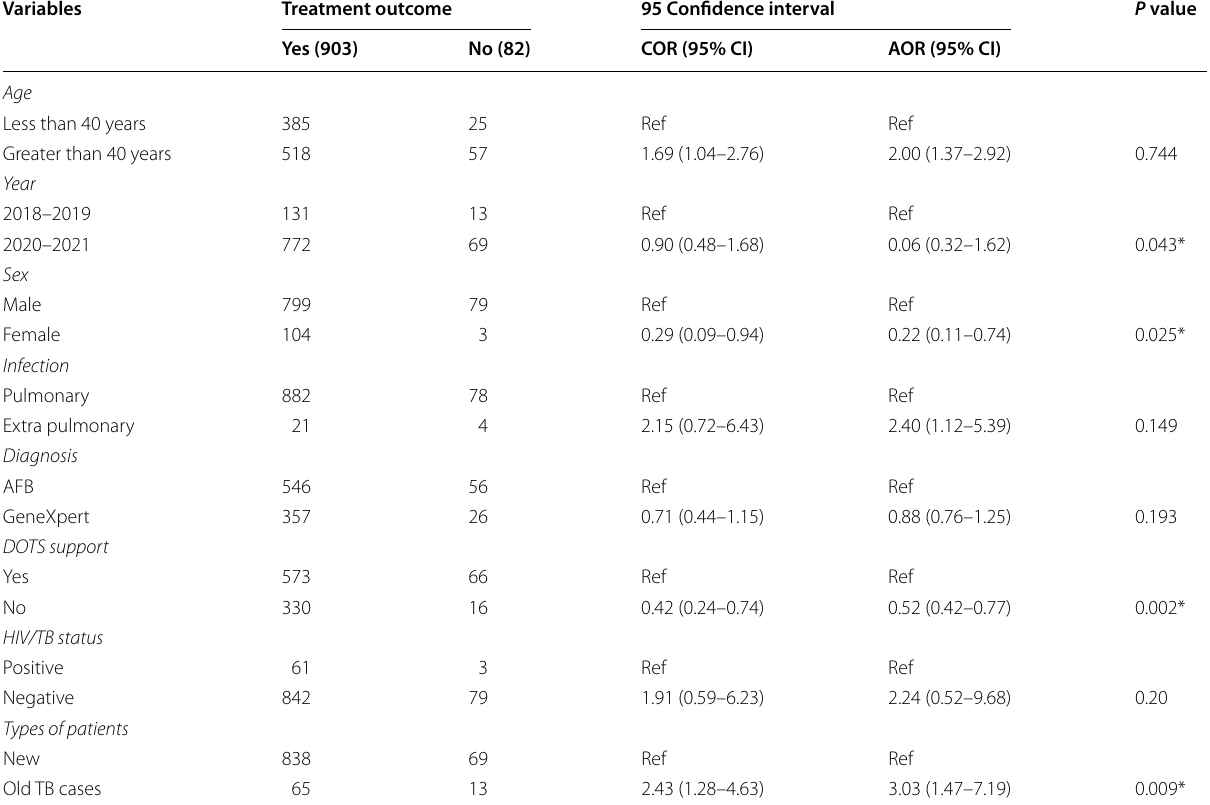
Table 3 Logistic regression analyses of factors associated with treatment outcomes in TB patients attending the DOTS facilities in 21 referral hospitals in Kebbi